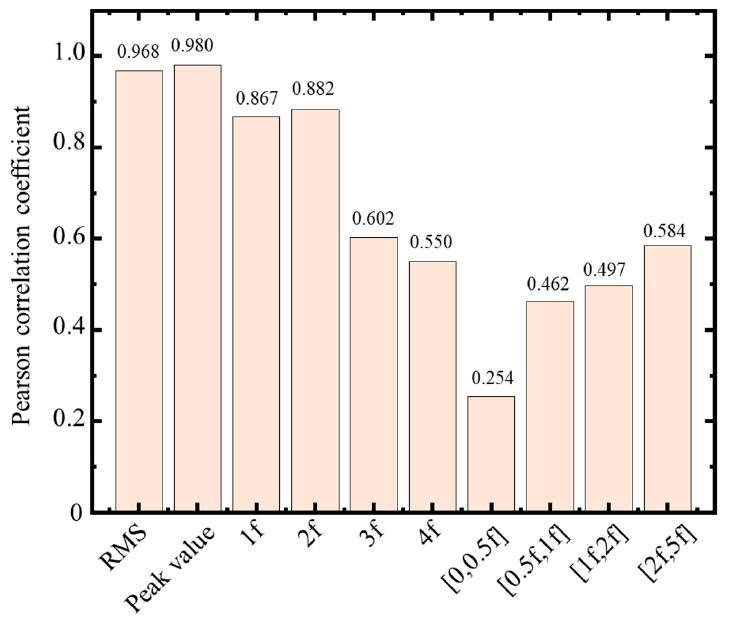
Figure 6. Pearson correlation coefficient of time- and frequency-domain handcrafted features for the unbalanced force.